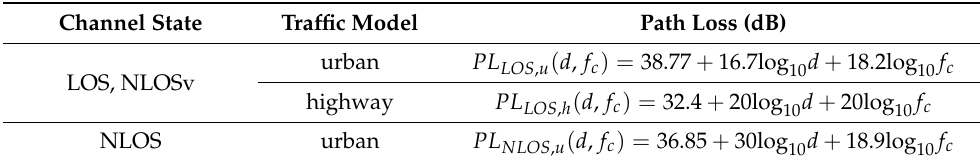
Table 1. Path loss in dB for V2X system model.